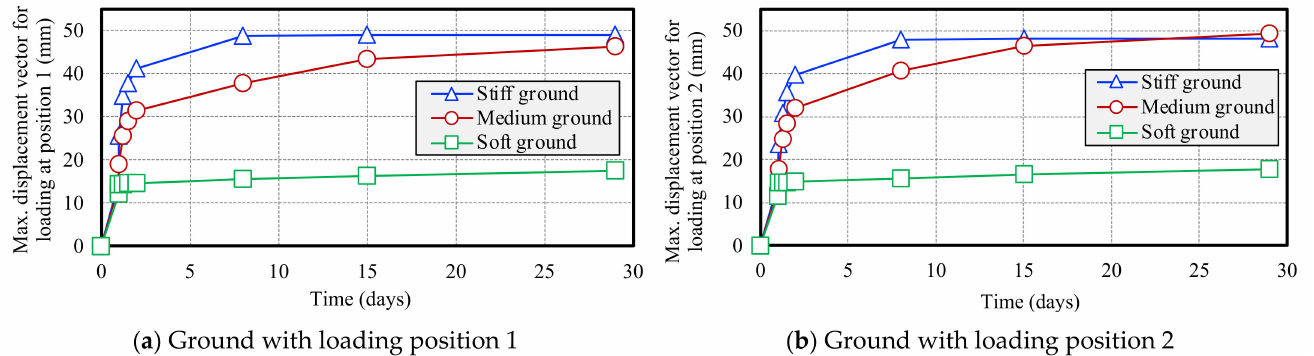
Figure 14. Top views of displacement contour for double boreholes under the loading condition.